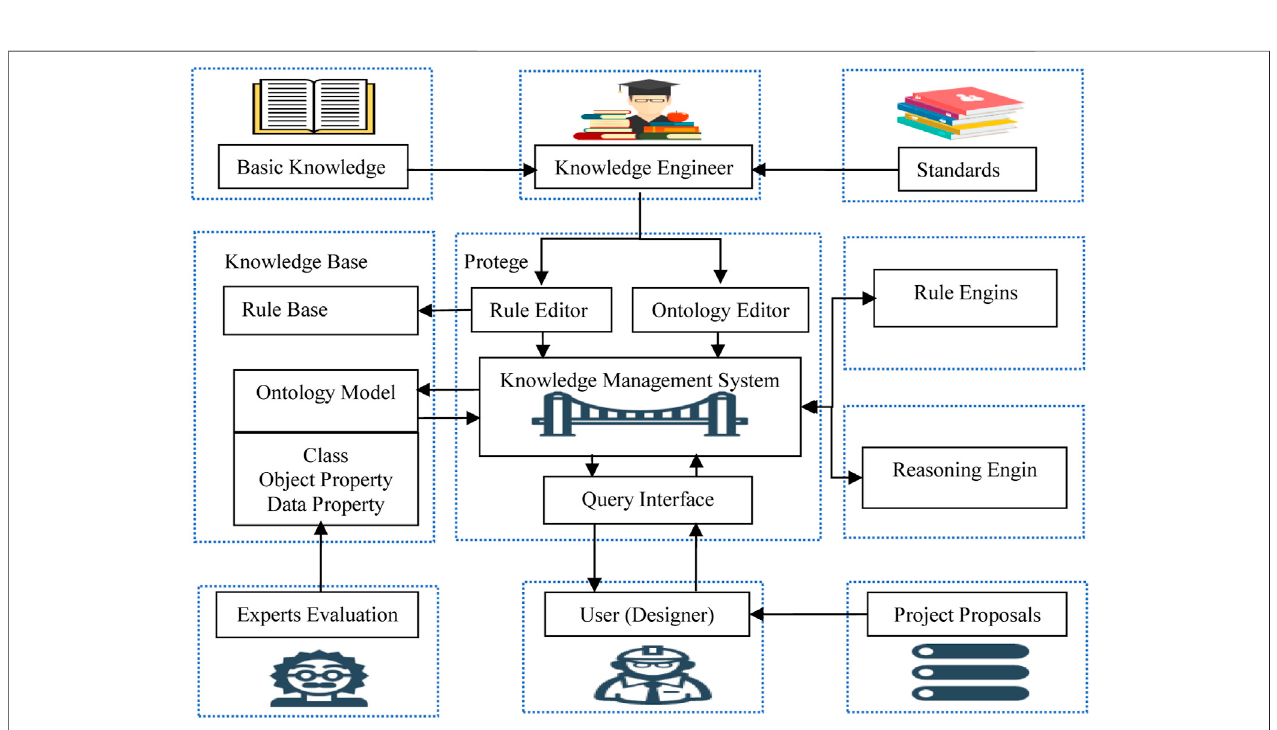
FIGURE 2 | The developed framework of